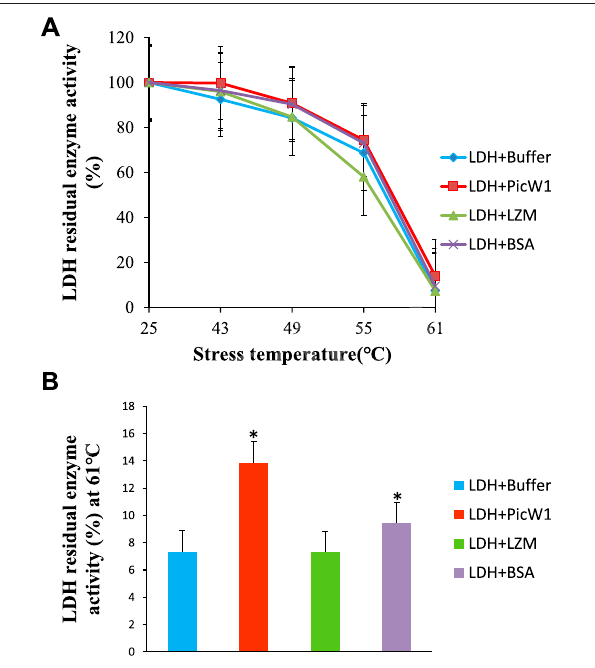
FIGURE 5 | Protective effect of PicW1 protein on LDH activity under high-temperature stress. (A) LDH solution was cultured in high-temperature water bath (43, 49, 55, and 61 ° C) for a speci fi c time in the presence of PicW1, BSA, and LZM. The results were expressed as LDH residual enzyme activity (%) relative to the activity before stress. Error bar represents ±SEM fromatleastthreereplicates. (B) HeatstresstreatmentofLDHinthepresence and absence of PicW1 at 61 ° C. Signi fi cant differences in the LDH enzyme activity retention areindicatedas* p < 0.05, whichwereevaluated witha t -test ( t -test was performed on the protective effect of every two proteins of LZM, PicW1, and BSA on